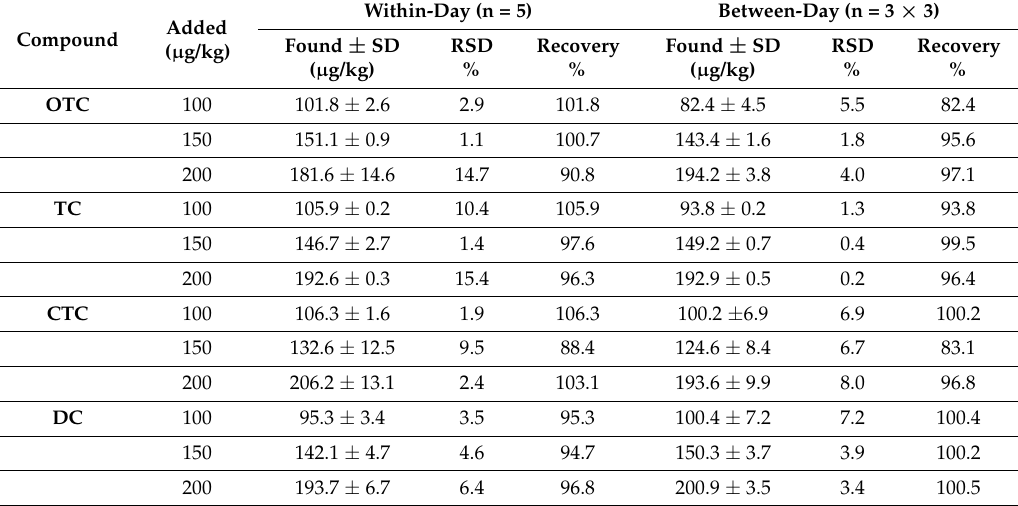
Table 4. Within-day repeatability, between-day precision and Accuracy for the determination of OTC, TC, CTC and DC in milk.